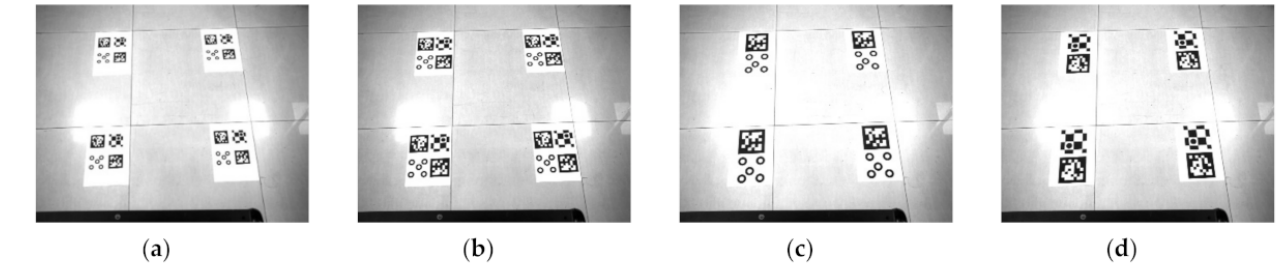
Figure 15. Experiment images under different marker dimensions: ( a ) Markers dimension is 67.5 × 67.5 mm; ( b ) Markers dimension is 90 × 90 mm; ( c ) Markers dimension is 126 × 126 mm; ( d ) Markers dimension is 126 × 126